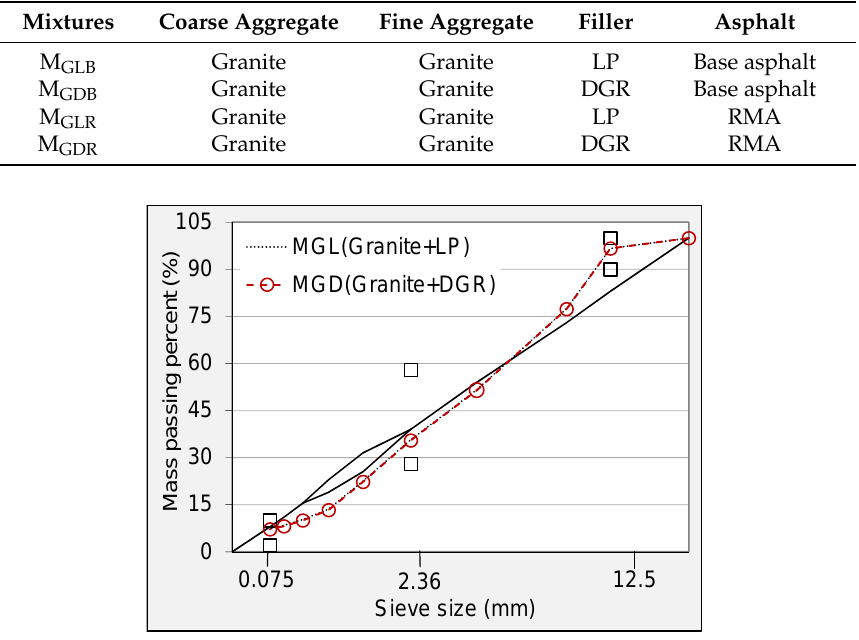
Figure 2. Hybrid gradations used in this research.